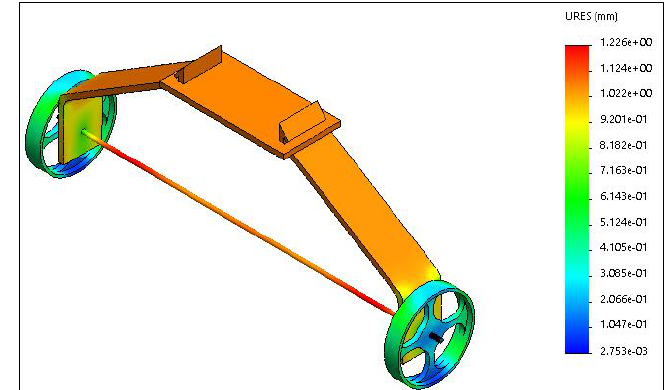
Figure 9: Result of the displacement analysis for the Drop test. Source: Authors, (2021).